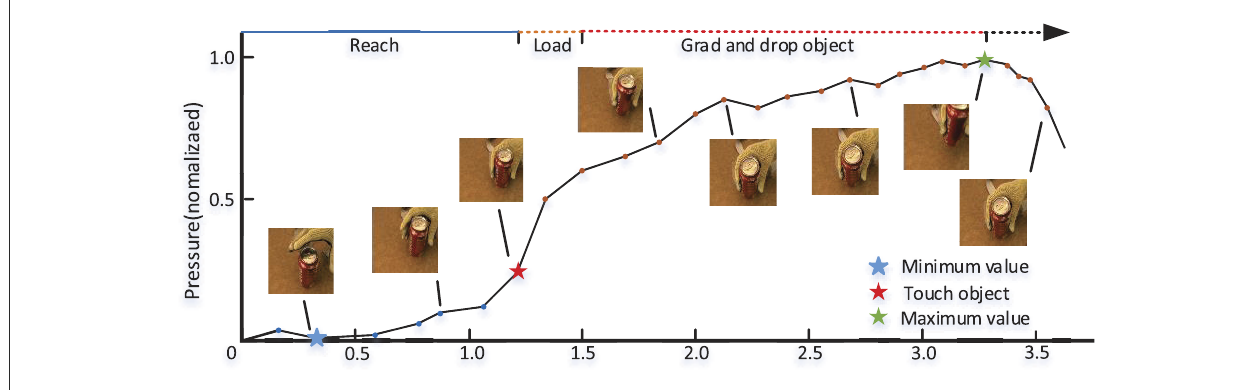
FIGURE2 A typical interaction sequence of grasping objects by hand.